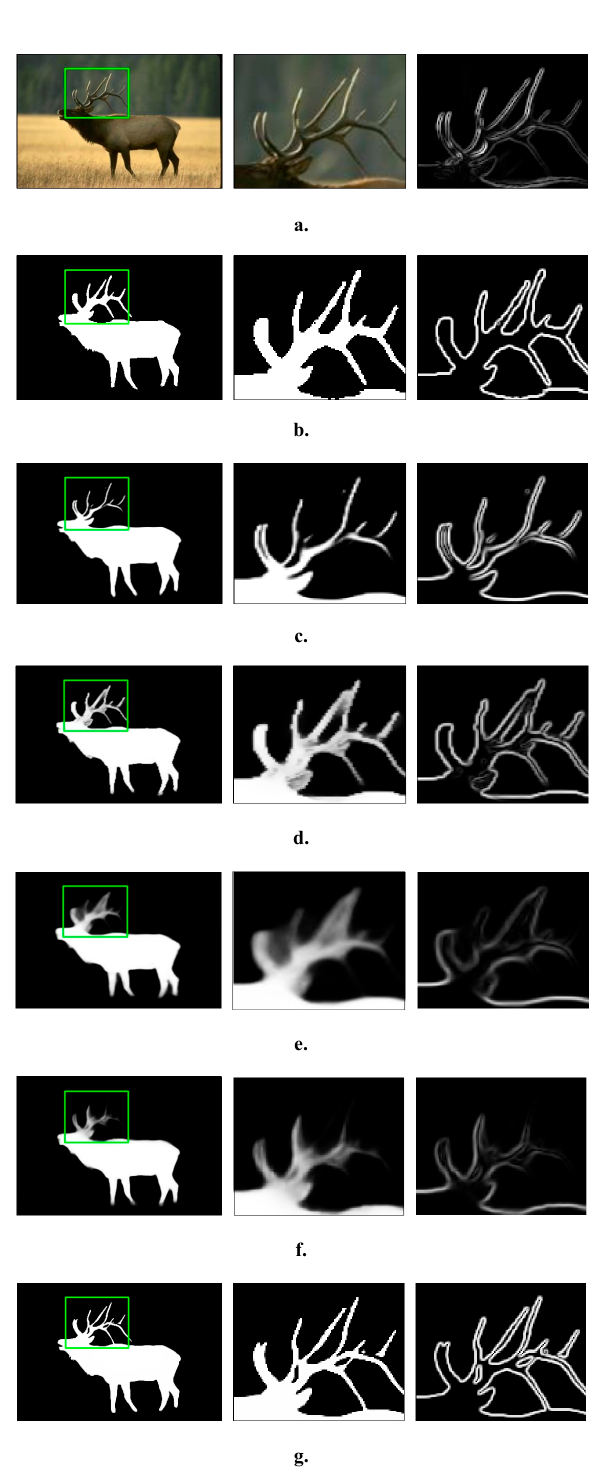
Figure 6. Qualitative comparison of the proposed method (a. Image; b, Ground Truth; c, BASNet[23]; d, AFNet[32]; e, PiCaNet[34]; f, RAS[37]; g, Proposed MEAN)